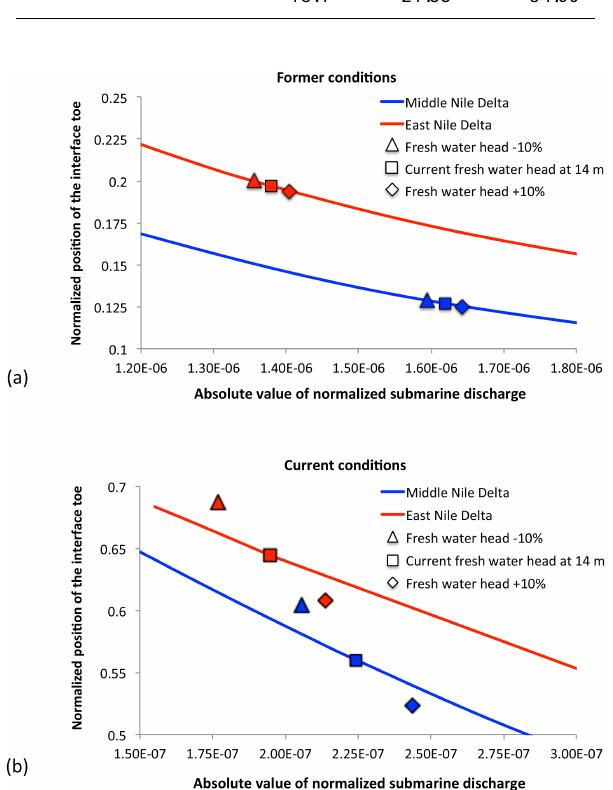
Fig. 5. Seawater intrusion performance curves for the middle and east Nile Delta aquifer cross sections for different groundwater head conditions at the inland boundary. Normalized intrusion toe position, l T / L , is shown as a function of the normalized subma- rine groundwater discharge q SD /(KL) for (a) former values of net recharge and associated q SD /KL (range of higher q SD /(KL) values in the x axis scale), and (b) current values of net recharge and as- sociated q SD /(KL) (range of lower q SD /(KL) values in the x axis